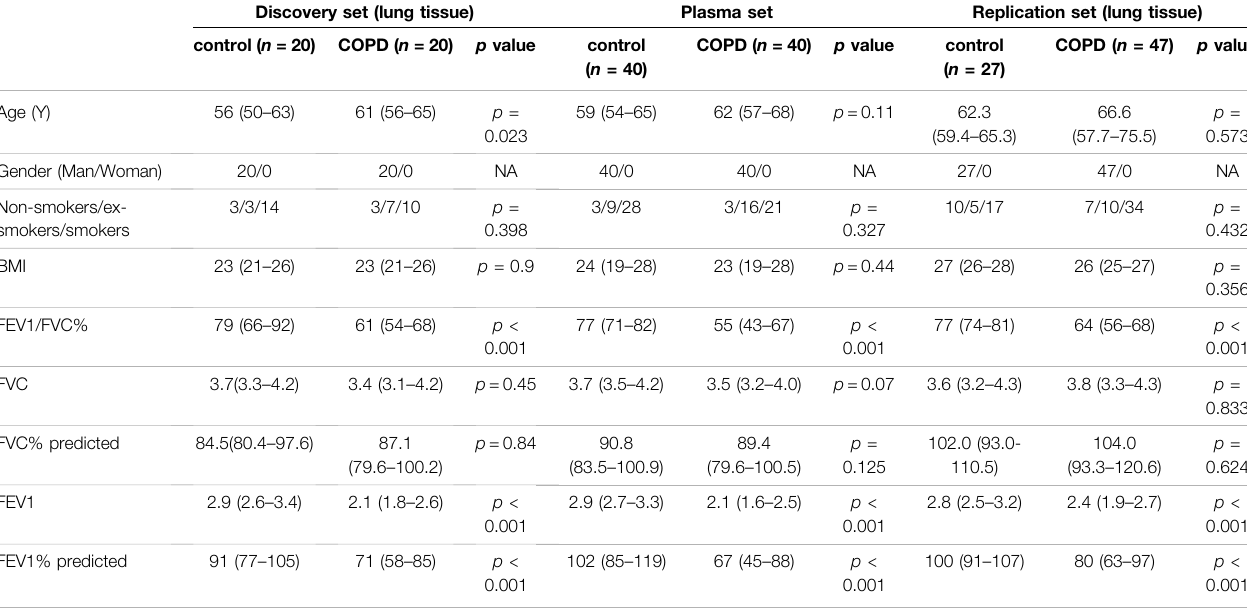
TABLE 1 | Fundamental Characteristics of Study Subjects.